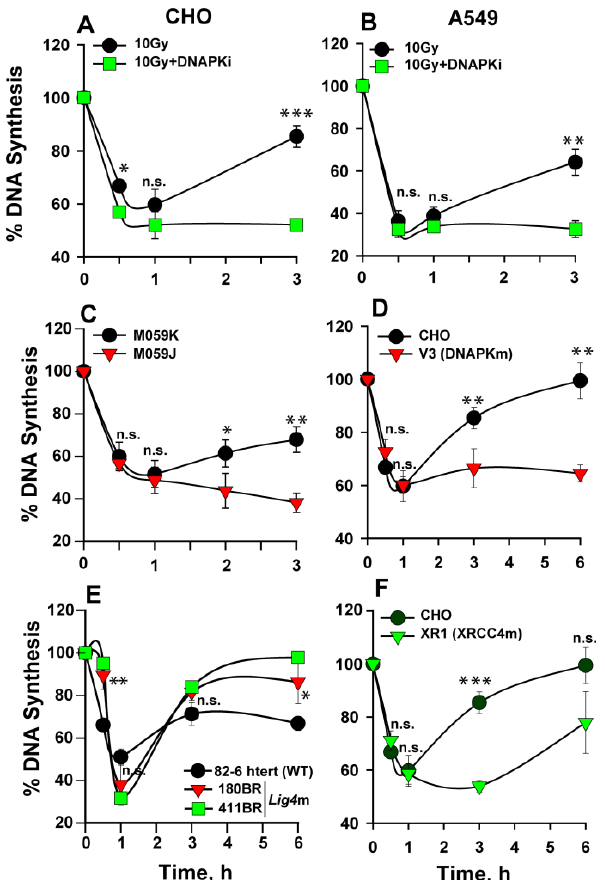
Figure 3. DNA-PK contributes to the recovery from the intra-S-phase checkpoint. ( A ) Percentage of DNA synthesis over unirradiated controls measured after exposure to 10 Gy of IR in the presence or absence of a DNA-PK inhibitor in CHO cells. ( B ) As in ( A ) for A549 cells. ( C ) As in ( A ) for M059K (wt) and M059J (DNA-PKcs mutant) cells. ( D ) As in ( A ) for CHO wt and the DNA-PK mutant, V3. ( E ) As in ( A ) for human fibroblast wt and Lig4 mutant cell lines. ( F ) As in ( A ) for CHO wt and the XRCC4 mutant, XR1. Error bars represent standard deviation from 3 independent experiments. The significance of differences between individual measurements is indicated by * symbol: * p < 0.05, ** p < 0.01, *** p < 0.001; n.s. non-significant. Results for 411BR cells are derived from a single